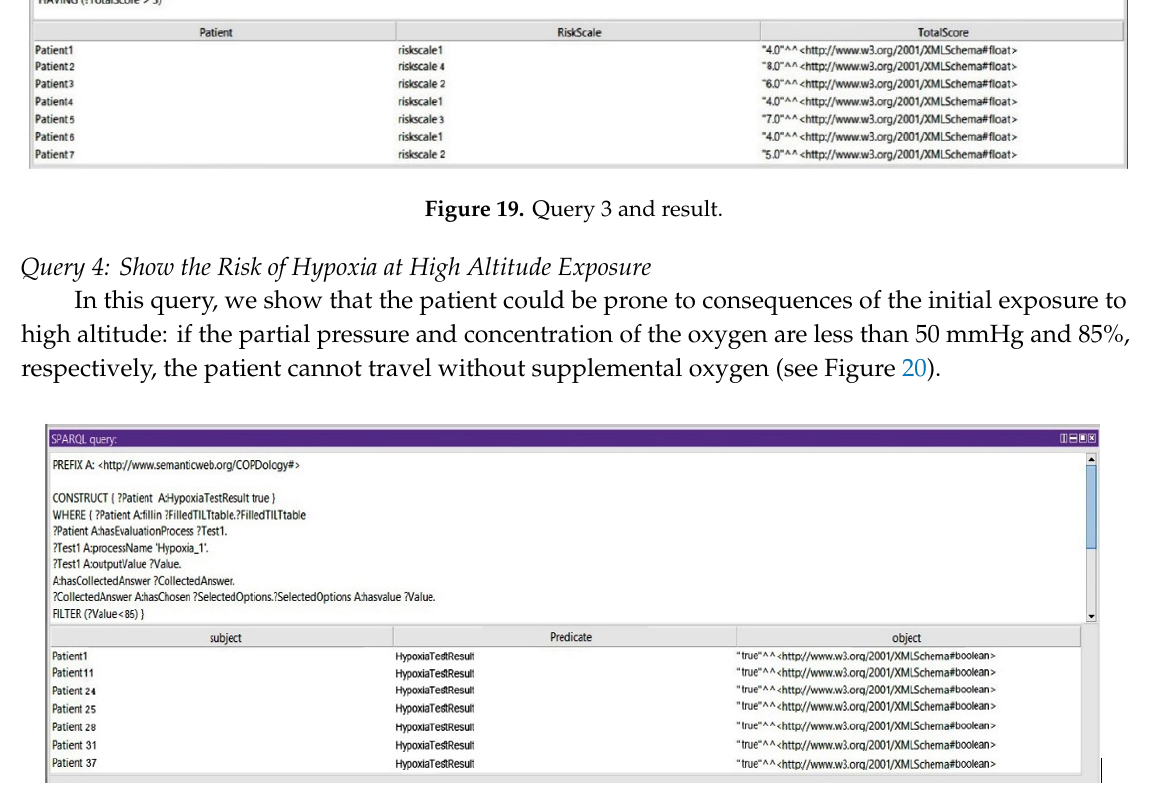
Figure 20. Query 4 and result.